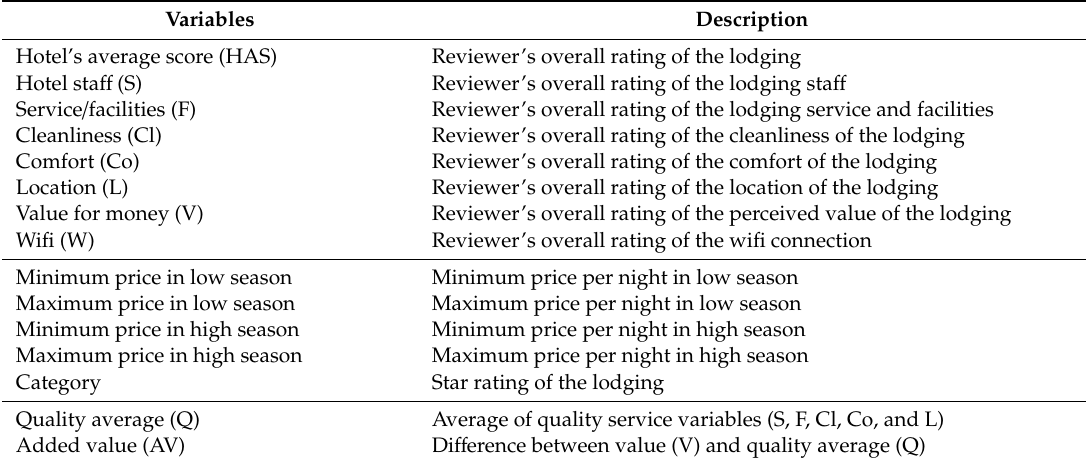
Table 1. Description of